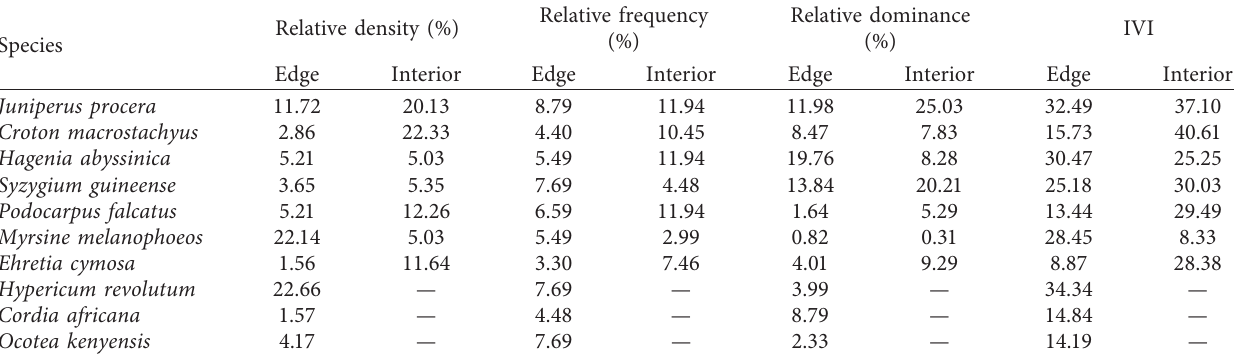
Table 6: IVI of woody species in the edge and interior